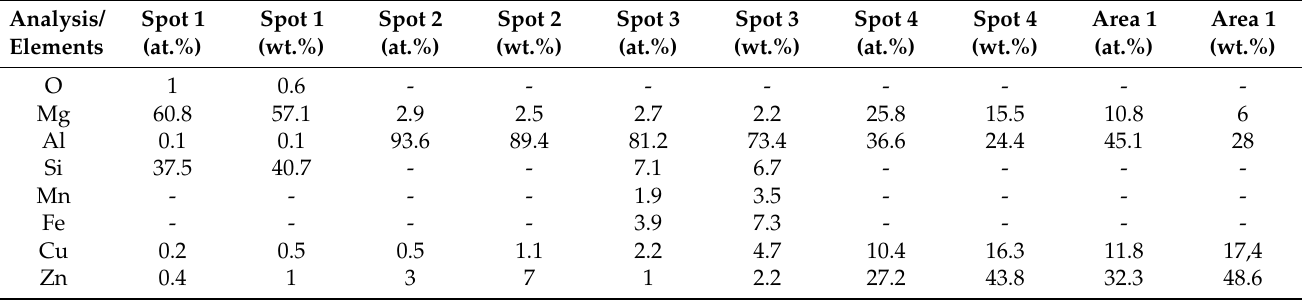
Figure 9. FESEM backscatter electron microstructure with EDS on selected phases for specimen 1MH. Table 8. Elemental composition of the manufactured alloy in sample 1MH obtained by EDS.